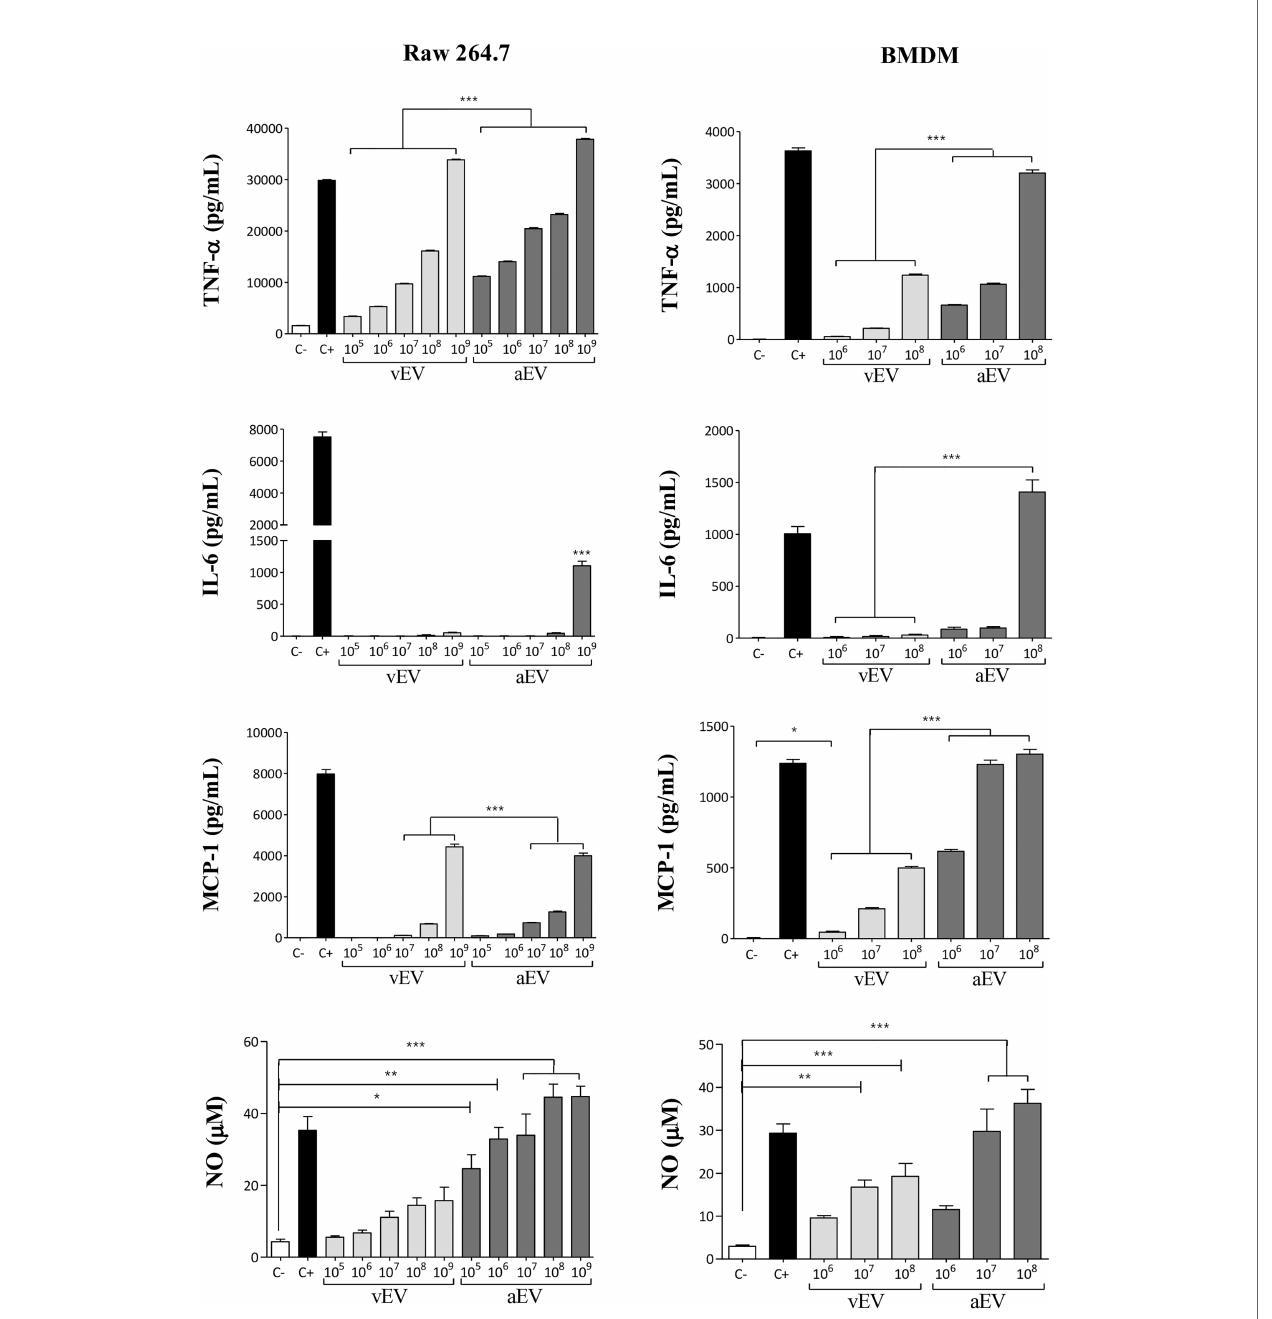
FIGURE 4 | Comparative macrophage response upon stimulation with vEVs and aEVs. The graphics show the cytokine (TNF- a and IL-6), chemokine (MCP-1), and nitric oxide (NO) concentrations in culture supernatants of RAW 264.7 macrophages (left column) and BMDM (right column) co-incubated for 48 h with increasing concentrations of vEV or aEV, as indicated. C − , PBS (negative control); C+, 1 µg/ml LPS (positive control). Standard deviations are shown with bars and signi fi cant results are indicated as * p < 0.05, ** p < 0.01, and *** p <